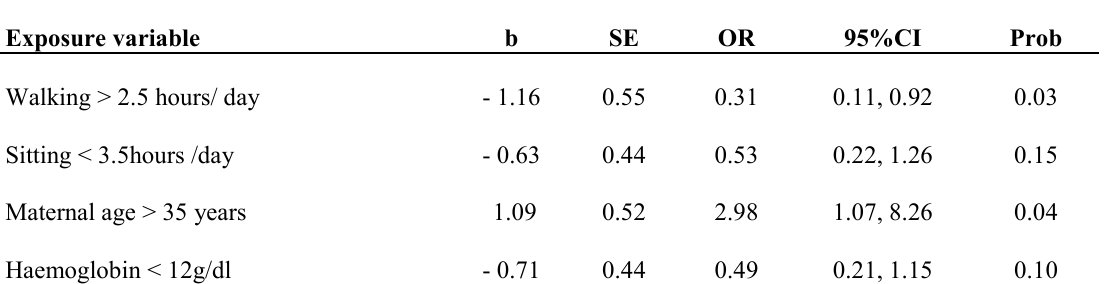
Table 3 Adjusted odds ratios for spontaneous